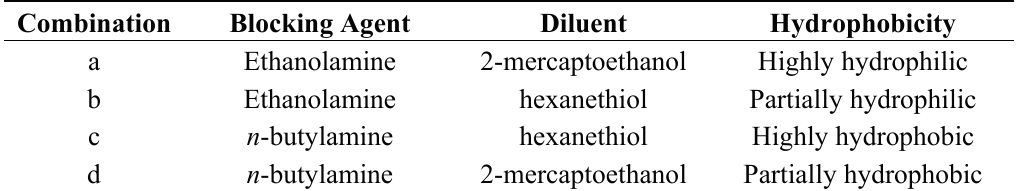
Table 2. Summary of combinations of blocking agent and diluent with corresponding hydrophobicity.